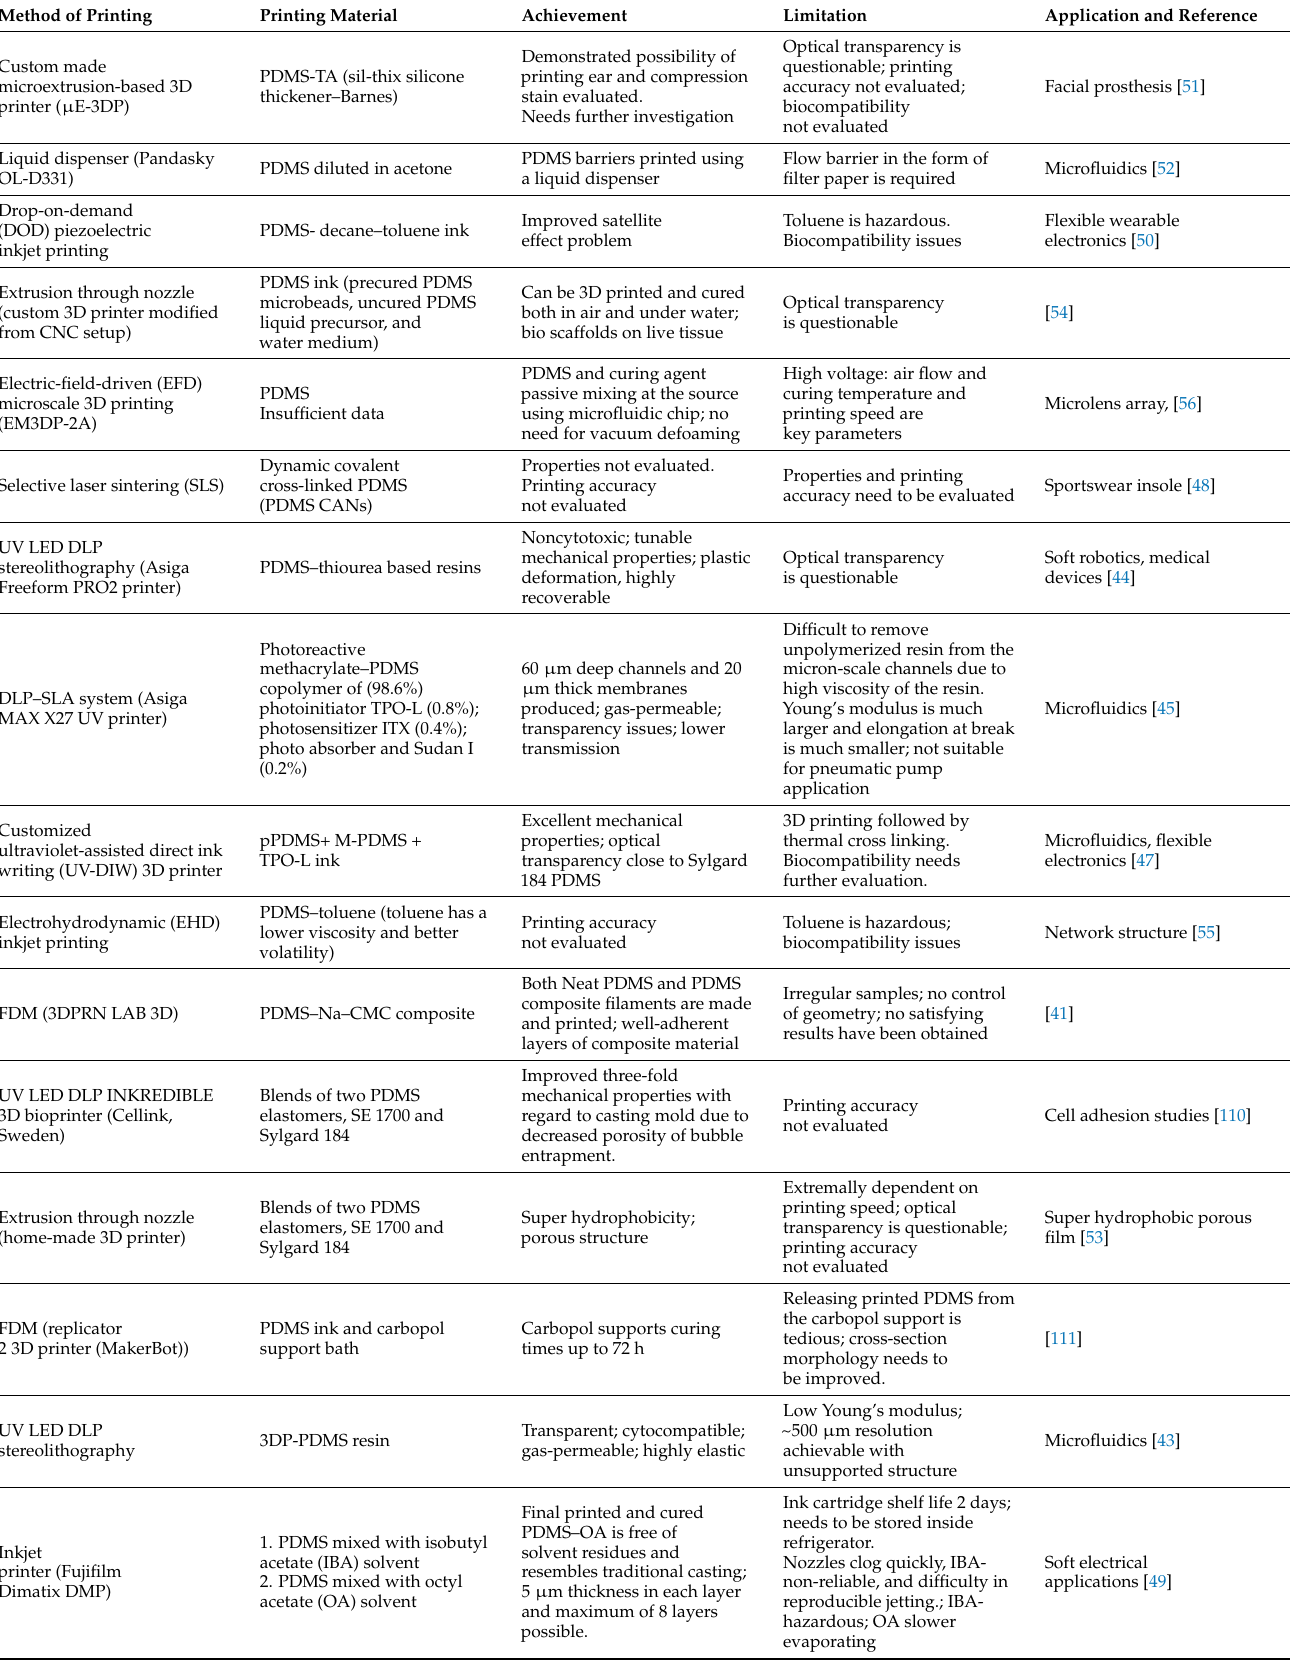
Table 3. Direct printing methods for PDMS microfluidic